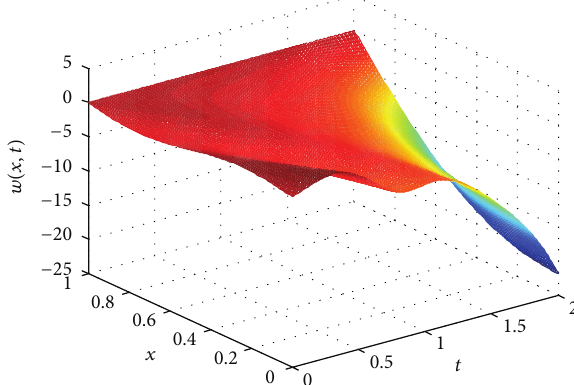
Figure 1: The response of the open-loop system.